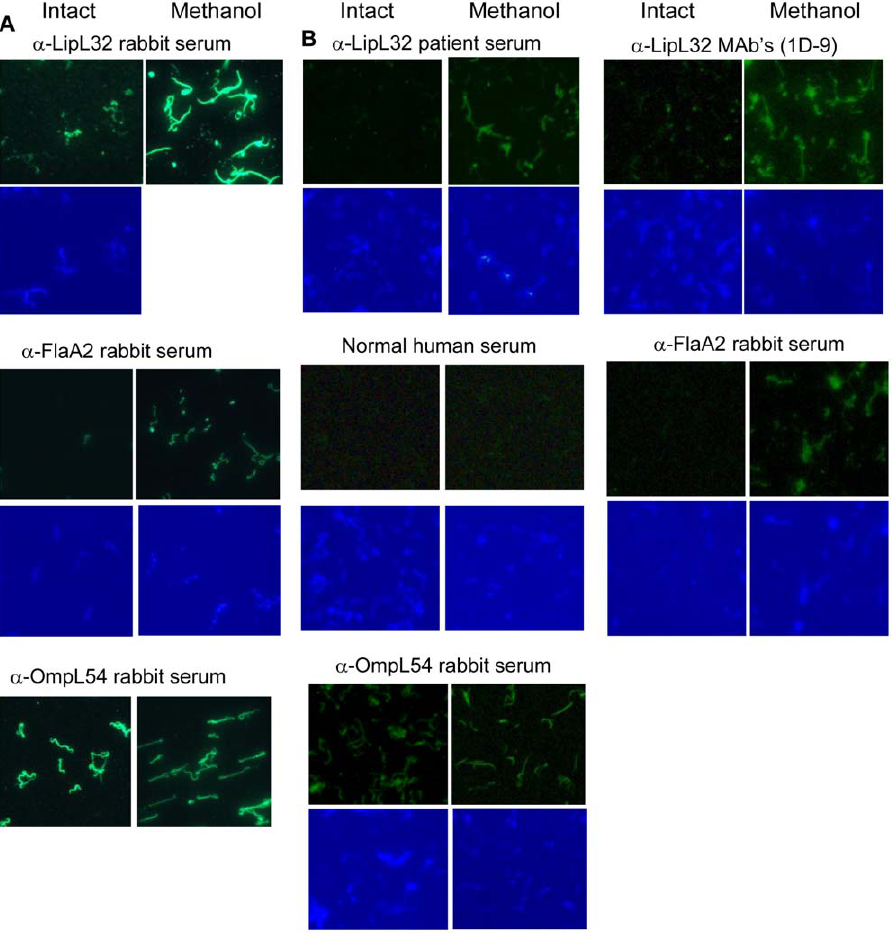
Figure 3. Localization of LipL32 by surface immunofluorescence assay (IFA). Intact or membrane-permeabilized spirochetes were probed with immune sera. Binding of rabbit antibodies to leptospires was detected with Alexa Fluor 488 conjugated goat anti-rabbit IgG fragments. Binding of LipL32 monoclonal antibodies was detected with Alexa Fluor 488 conjugated goat anti-mouse IgG fragments. Binding of LipL32 antibodies purified from leptospirosis patient sera were detected with Alexa Fluor 488 conjugated goat anti-human IgG fragments. A DAPI counterstain was used to demonstrate the presence of spirochetes. The data is representation of four (A) or three (B) experiments performed separately. The identities of individual proteins recognized by the particular antibody reagent are indicated on the top of each column.